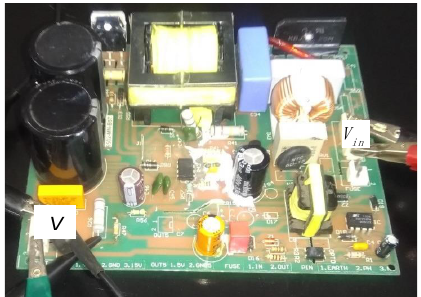
Figure 6. The experimental setup of boost converter.